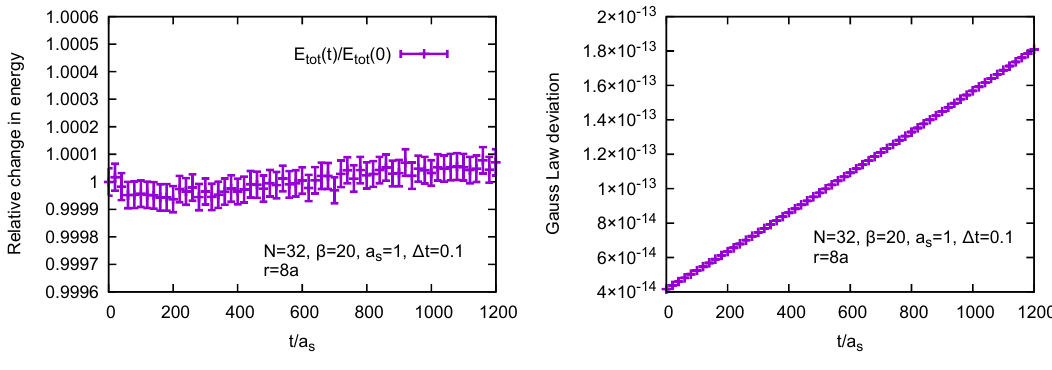
Figure 14 . Energy conservation (top) and Gauss’s Law preservation (bottom) in the presence of sources at spatial distance r=a at β = 20